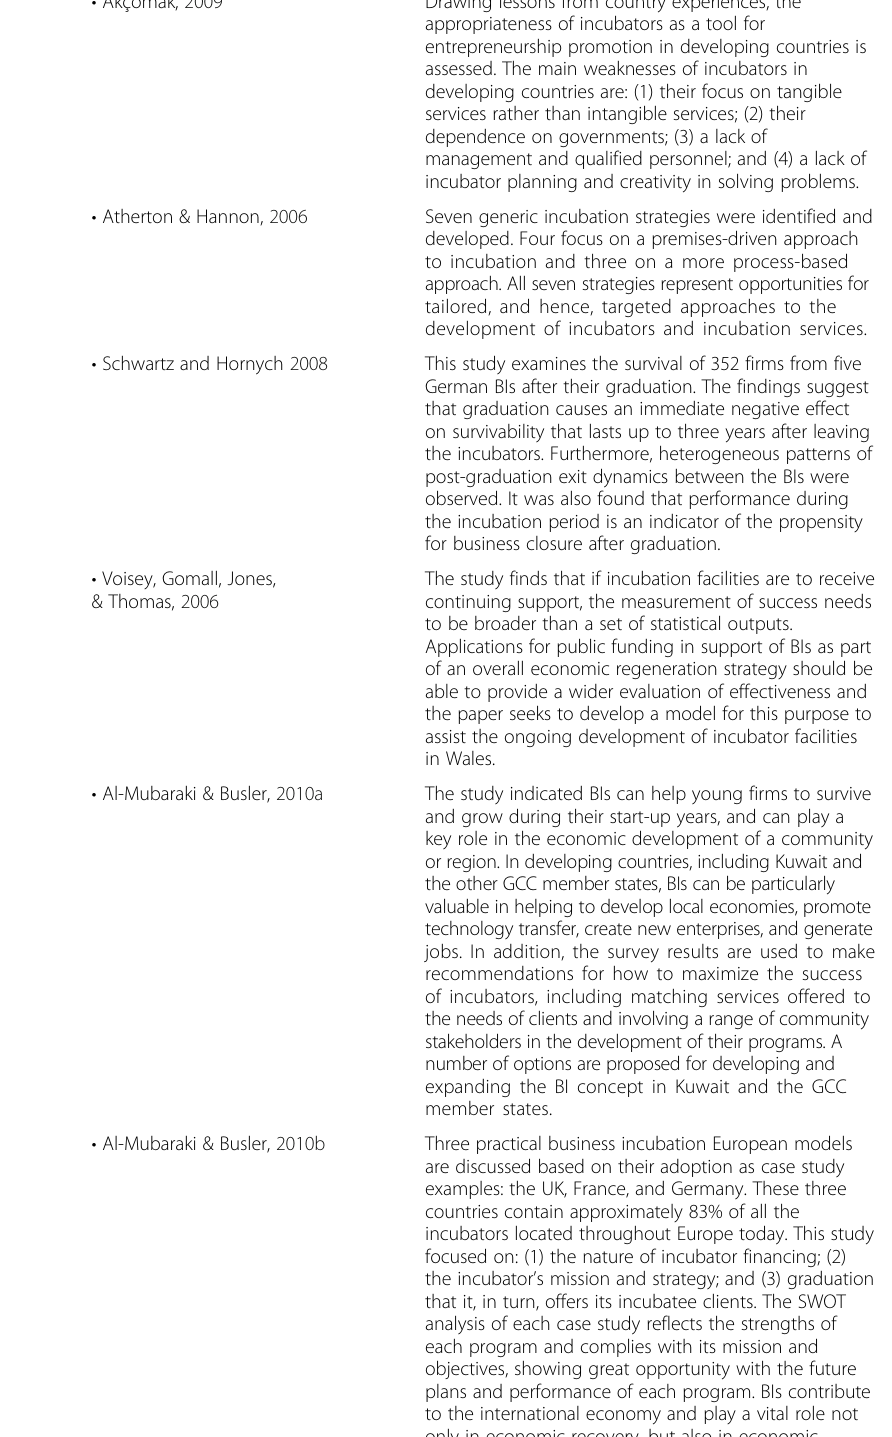
Table 1 Incubators: evidence from the literature